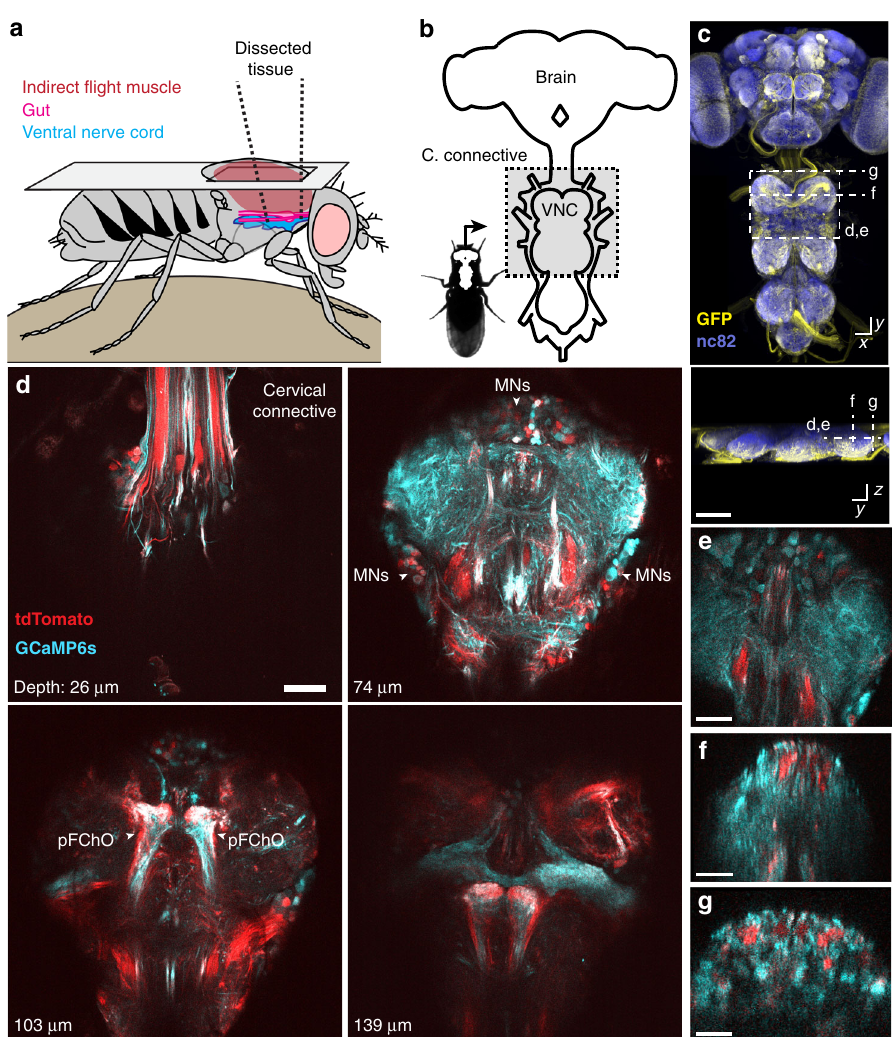
Fig. 1 Dissection for imaging the adult Drosophila ventral nerve cord (VNC). a Schematic of the dorsal thoracic dissection. b Overview of newly accessible nervous tissue following thoracic dissection. c Confocal image of pan-neuronal driver line expression in the brain and VNC. Scale bar is 90 µ m. GFP (yellow) and neuropil (nc82, blue) are labeled. Dashed lines highlight the horizontal and coronal imaging modalities used in this study. d Horizontal sections of the VNC imaged at different depths in an animal expressing GCaMP6s (cyan) and tdTomato (red) throughout the nervous system ( GMR57C10> GCaMP6s ; tdTomato ). Motor neuron (MNs) cell bodies and prothoracic femoral chordotonal organ (pFChO) axon terminals are indicated (white arrowheads). Scale bar is 30 µ m. e Horizontal section imaging of the VNC. Scale bar is 35 µ m. f Coronal section imaging of the prothoracic neuromere. Scale bar is 50 µ m. g Coronal section imaging of the cervical connective. Scale bar is 35 µ m. Images in e – g were taken from fl ies expressing GCaMP6s and tdTomato throughout the nervous system ( GMR57C10> GCaMP6s; tdTomato